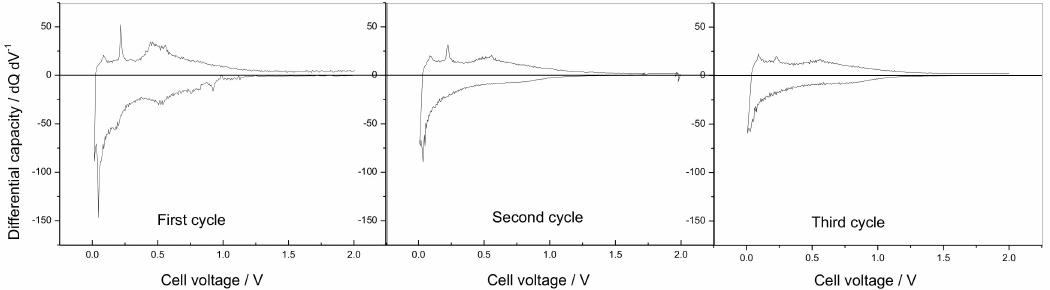
Figure 7. Voltage profiles recorded during the first three charge/discharge cycles for the Sn-RGO-based electrode. The cycles were conducted at 60 mA · g − 1 between 0.05 V and 2.00 V. The arrow indicates the progression of the cycles.